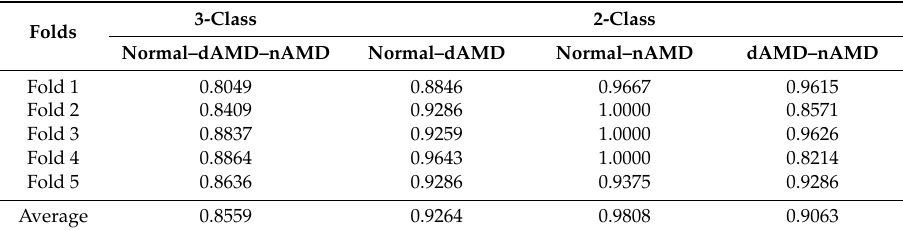
Table 3. Results obtained using five-fold cross-validation without preprocessing.